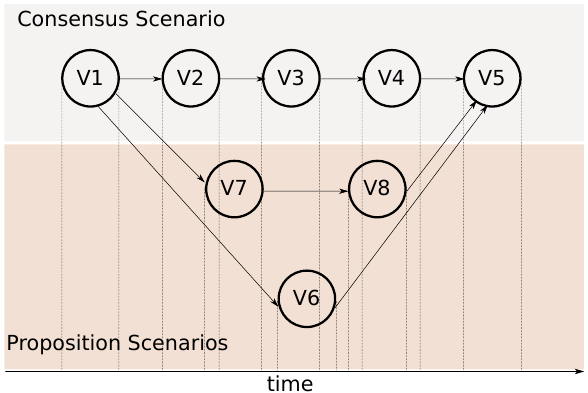
Figure 4. Workspace with two spaces for scenarios: Consensus space and propositions space